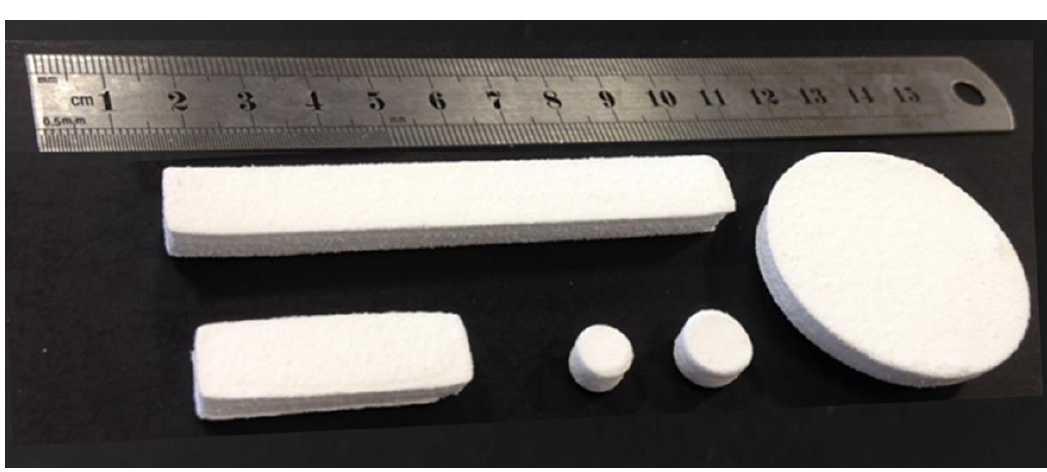
Figure 16. UHMWPE parts produced by laser sintering (LS) machine EOS P100.